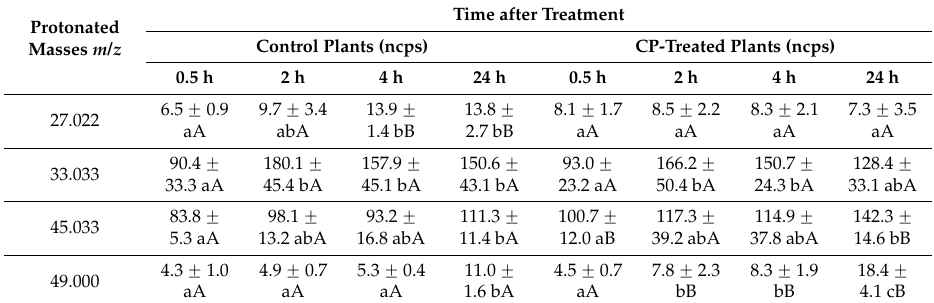
Table 3. Effect of 0.5, 2, 4, and 24 h of incubation with 150 µ M CP on VOC accumulation (in ncps) in A. thaliana